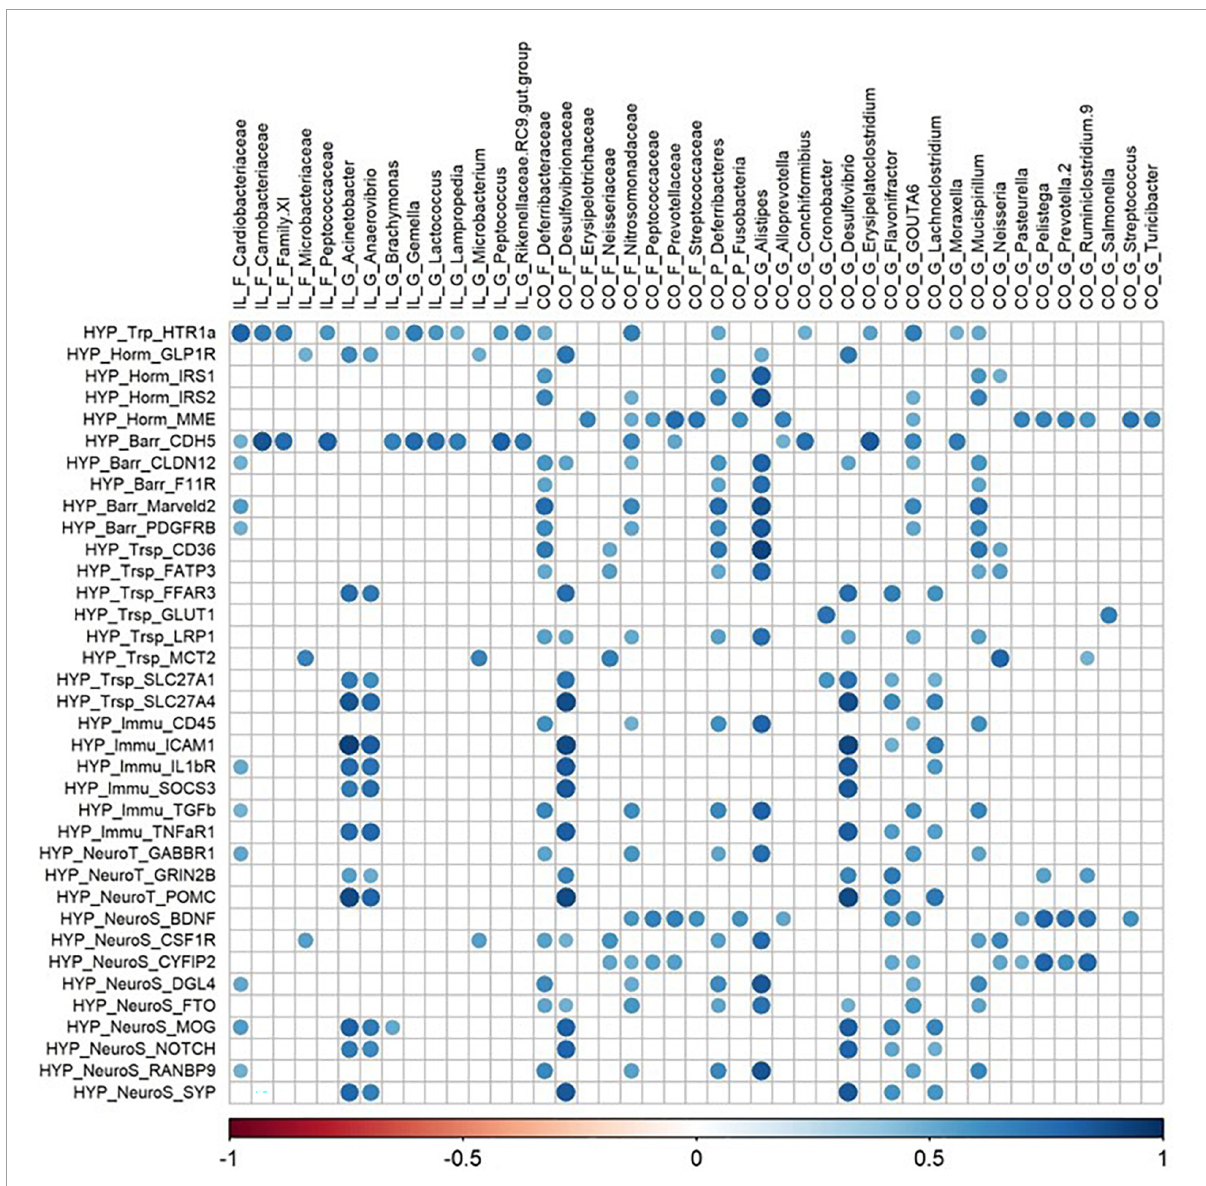
FIGURE5 Correlations matrix between hypothalamic relative gene expression and ileal and colonic microbiota (| r | ≥ 0.7, P < 0.05). IL, ileum; CO, colon; F, family; P, phylum; G, genera; HYP, hypothalamus; Trp, tryptophan pathways; Horm, endocrine function; Barr, barrier function; Trsp, transport-nutrient carrier; Immu, immune function; NeuroT, neurotransmitters; NeuroS,